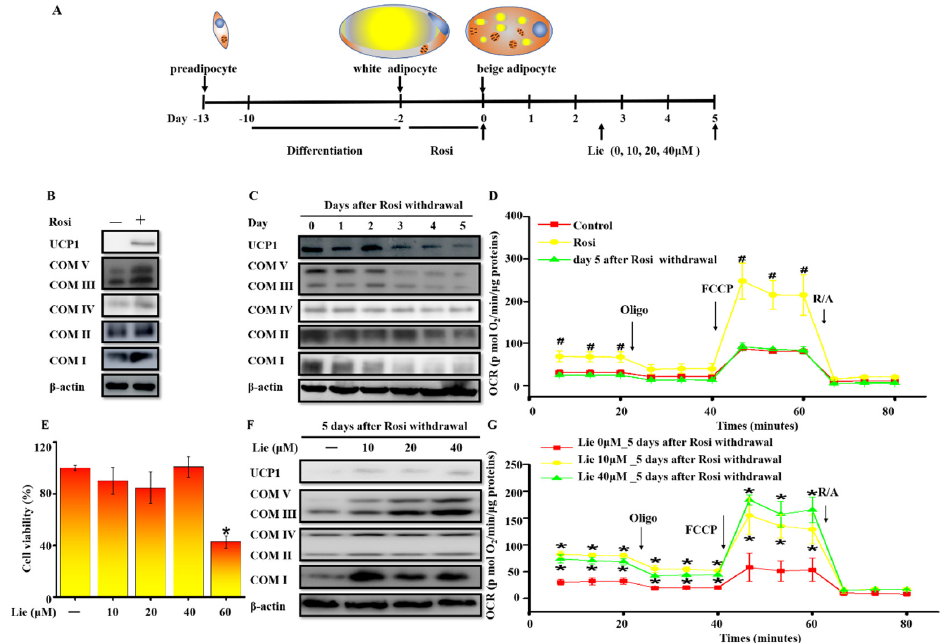
Figure 1. Liensinine (Lie) inhibited the beige adipocytes recovering to white adipocytes and retained their characteristics after rosiglitazone (Rosi) withdrawal in vitro . ( A ) Schematic illustration about in vitro experiments. Preadipocytes were differentiated into white adipocytes. Beige adipocytes were